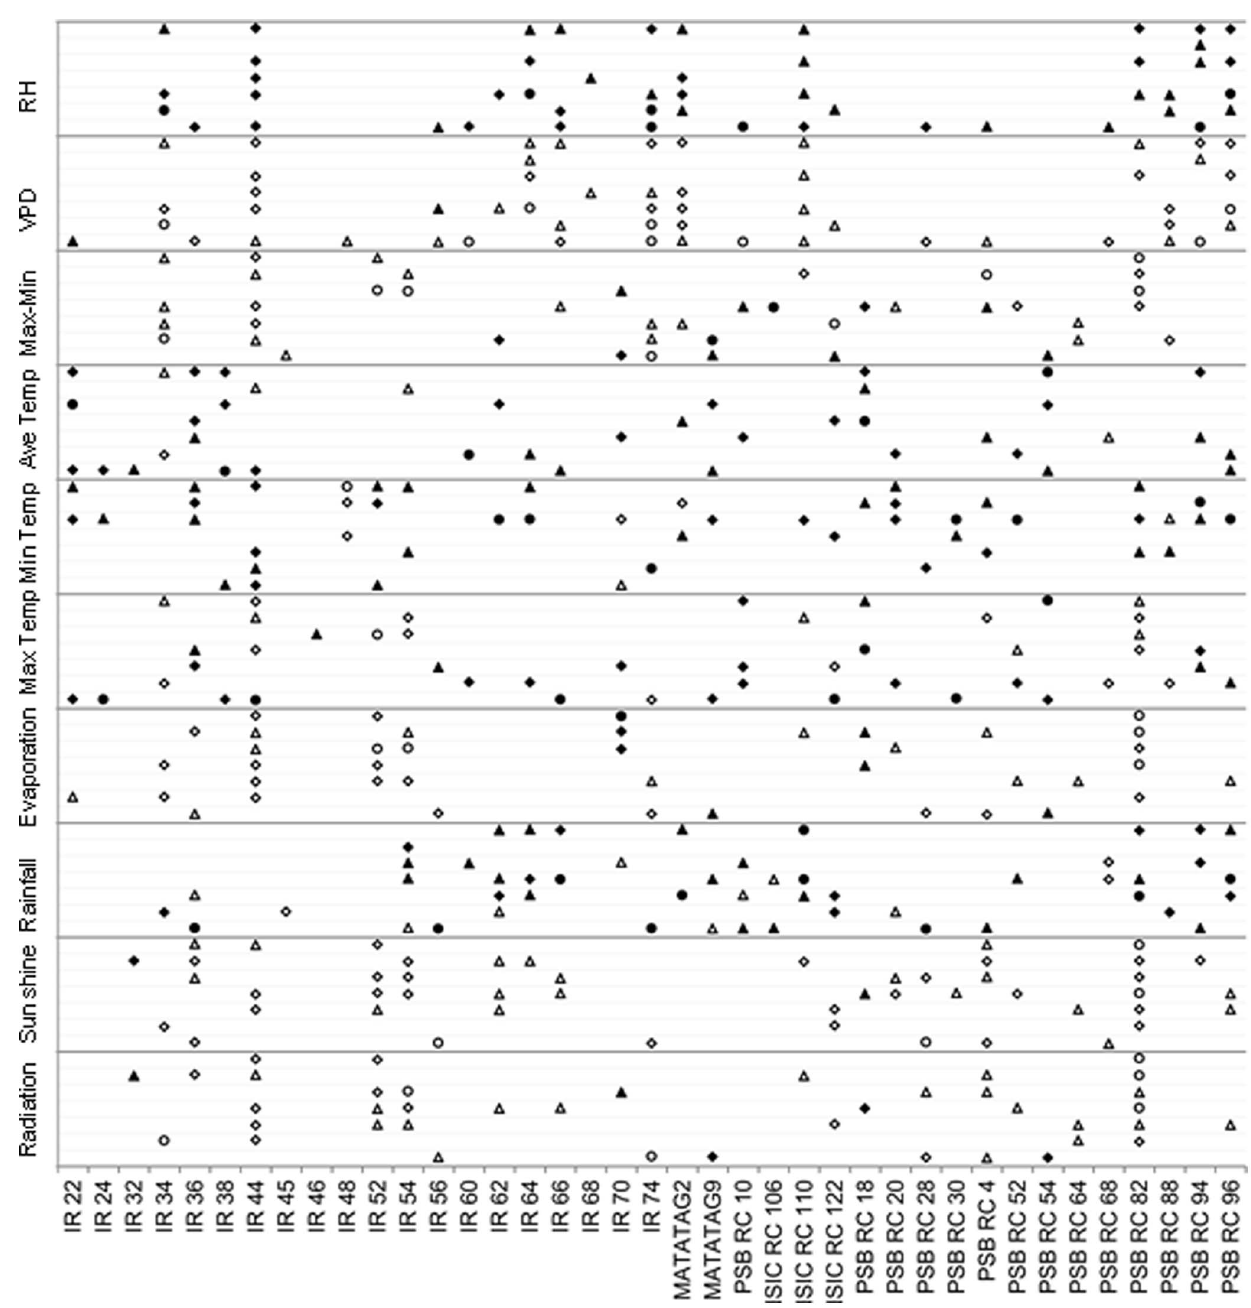
Figure 4. Association between PGWC and weather parameters for each variety across 8 seasons. Triangles, diamonds and circles represent significance at P , 0.10, P , 0.05 and P , 0.01 respectively. Blank and solid shapes represent negative and positive associations respectively. Gray lines from below to upper for each weather parameter represent 0–5, 6–10, 11–15, 16–20, 21–25, 26–30 and the whole grain filling stage.